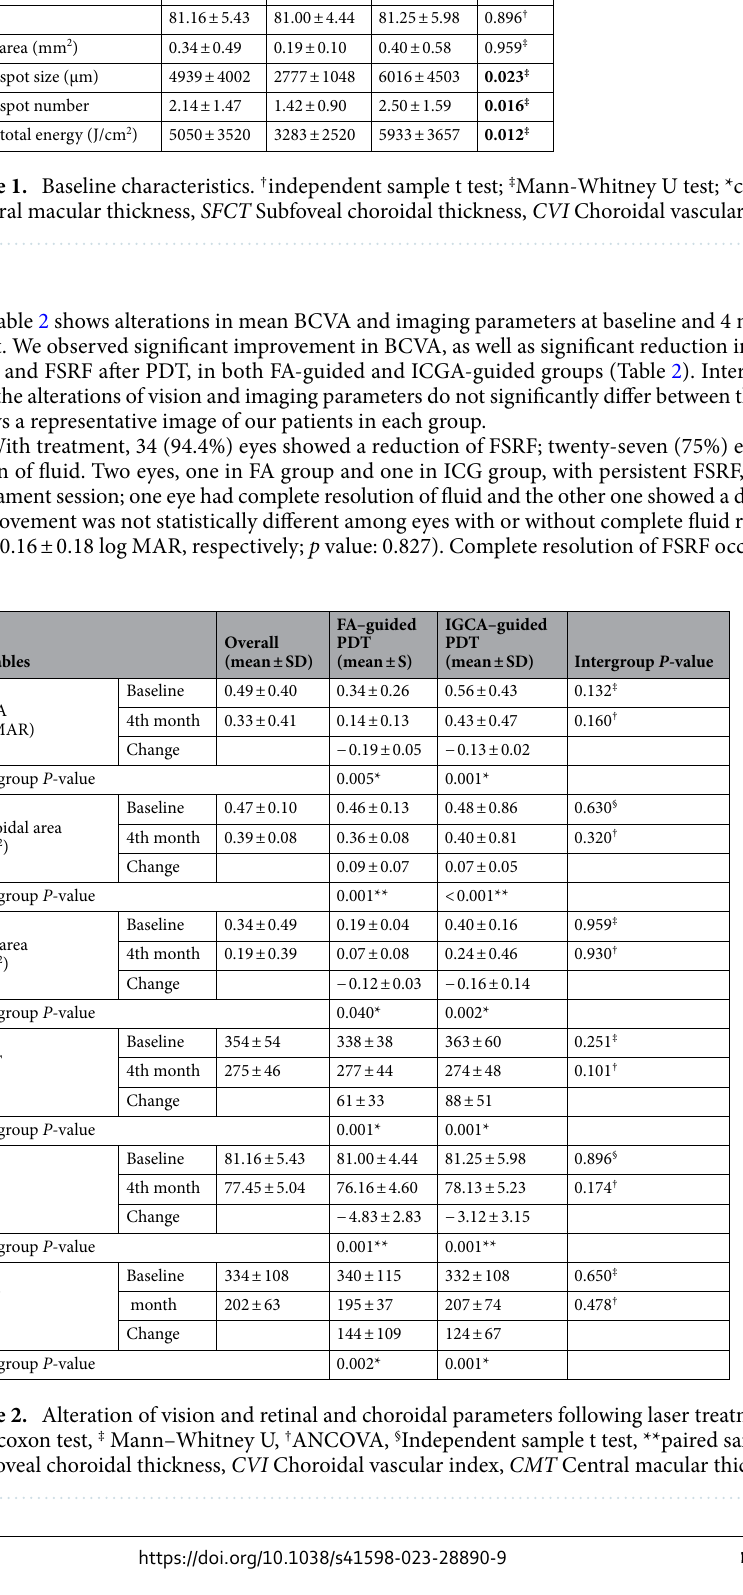
Table 2. Alteration of vision and retinal and choroidal parameters following laser treatment. Analyzed by: *Wilcoxon test, ‡ Mann–Whitney U, † ANCOVA, § Independent sample t test, **paired sample t test. SFCT Subfoveal choroidal thickness, CVI Choroidal vascular index, CMT Central macular thickness.